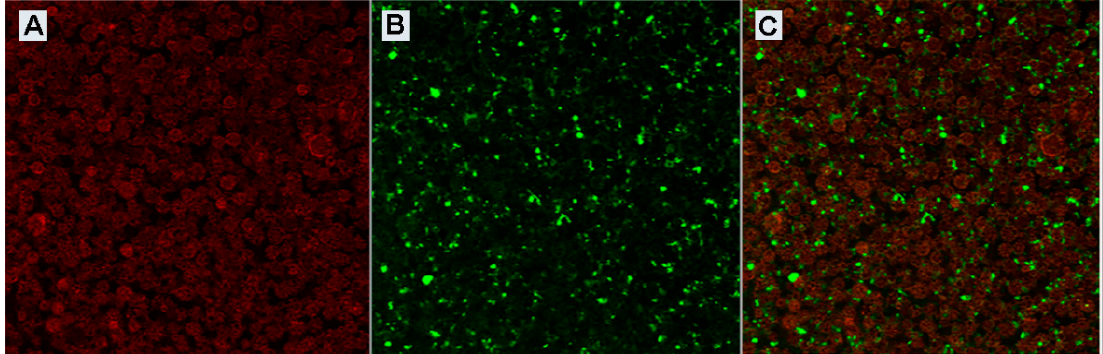
Figure 6. UV spectrum fd-OVA and fd-OVA FITC. ( A ) Rhodamine-loaded-MP confocal microscopy analysis. Rhodamine channel ( λ exc 550, λ em 600–700). ( B ) FITC channel ( λ exc 488, λ em 500–600). ( C ) Overlay of the channels.